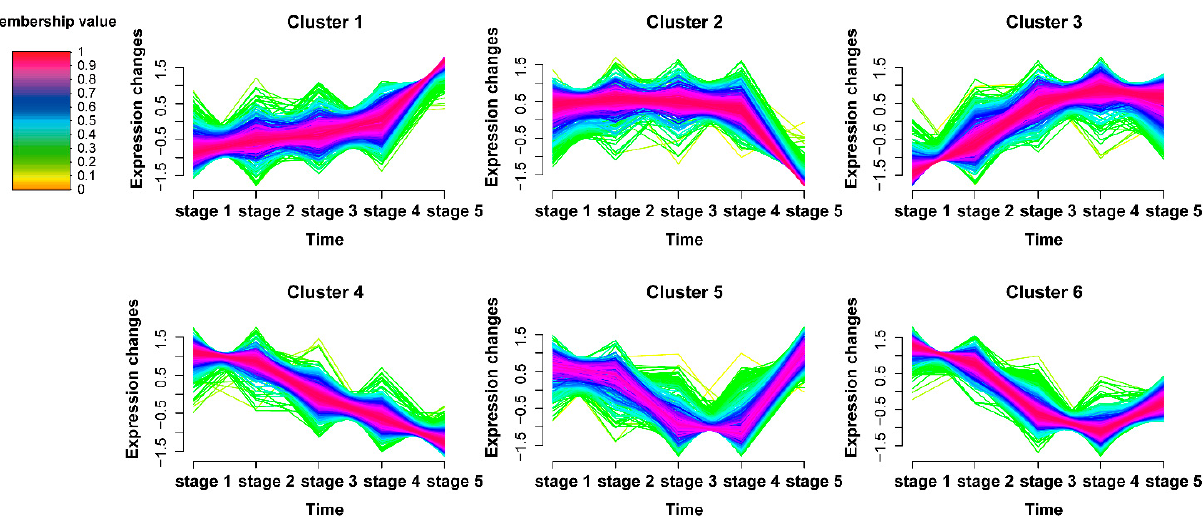
Figure 2. Time series analysis of DAPs: Time series analysis identified six distinct temporal patterns of proteins abundance using fuzzy c-means algorithm. The x-axis represents five developmental stages, while the y-axis represents normalized abundance changes of DAPs. The membership value represents the strength of the relationship between a protein and a corresponding cluster.